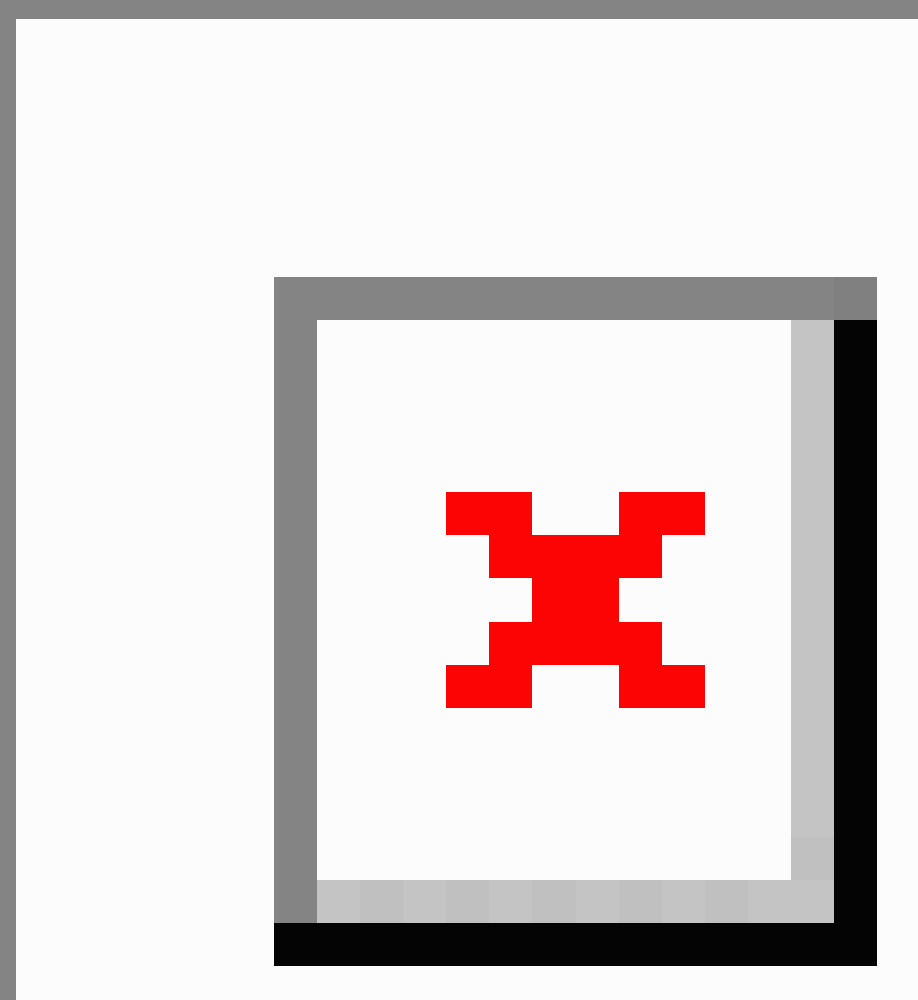
Figure 2. Patient disposition (a: 90-day observation period, b: 91 to 180